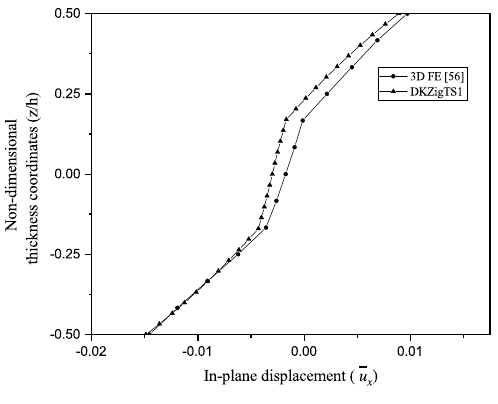
Figure 10: Through the thickness variation of In-plane displacement ¯ u x for panel